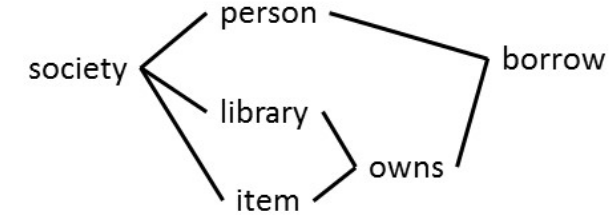
Fig. 10. Ontology chart, adapted from [55].